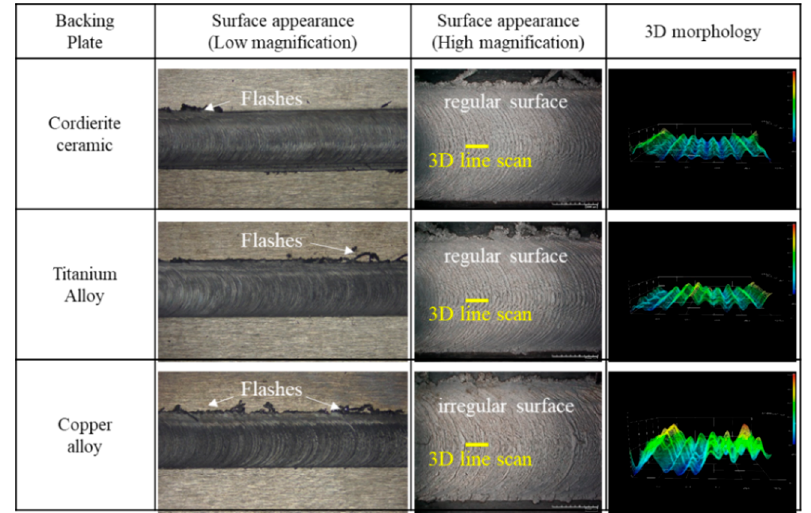
Figure 4. Surface morphology of the welds produced with different backing plate (BP) materials.